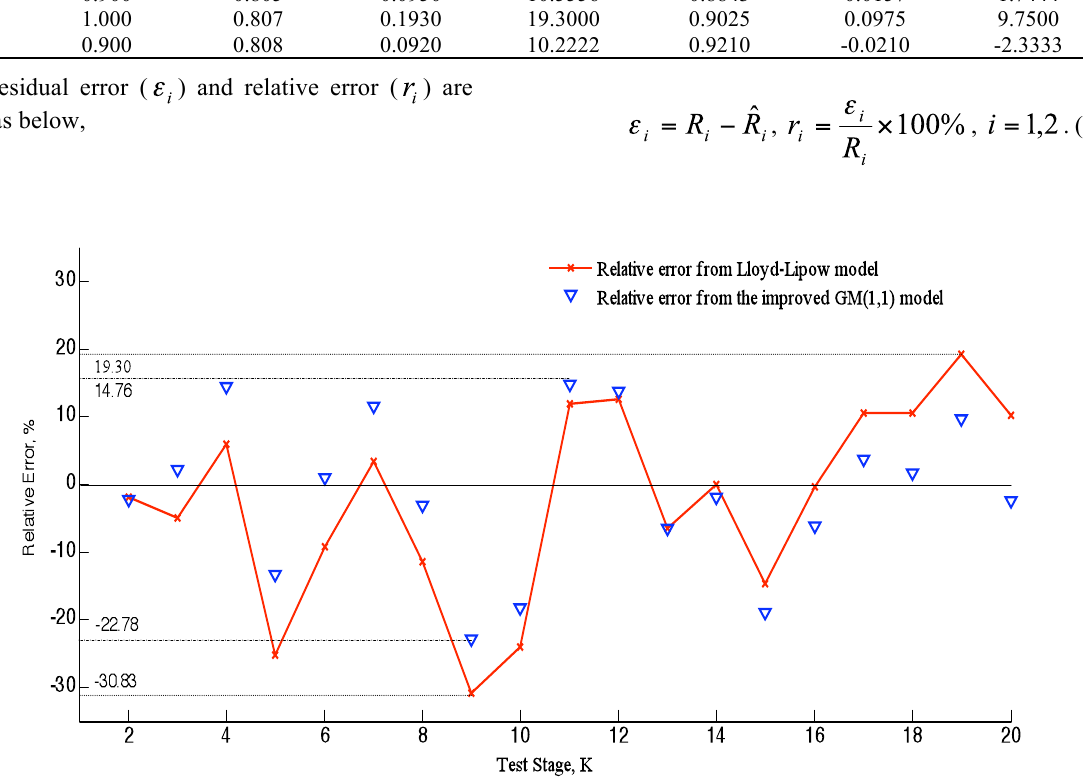
Fig. 2. Relative errors of predicted reliability values from the Lloyd-Lipow model and the improved GM(1,1) model.